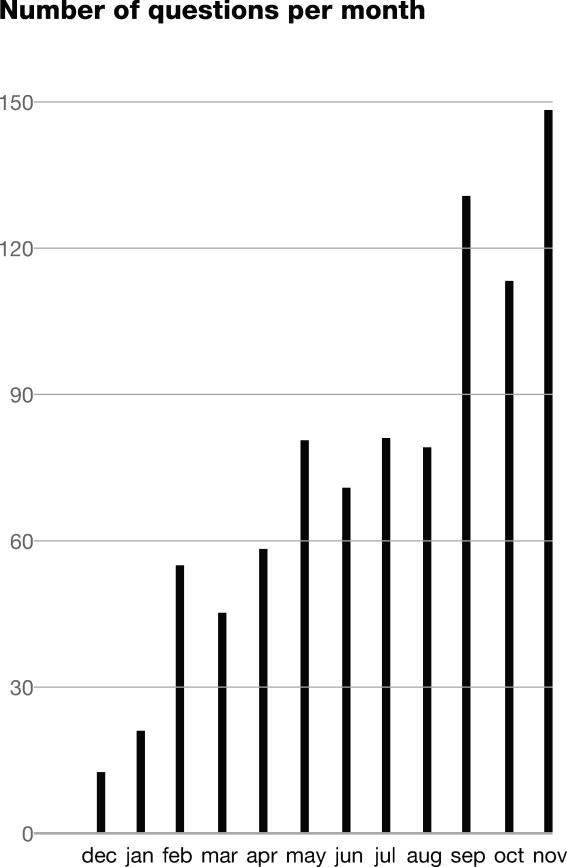
Number of Questions per Month